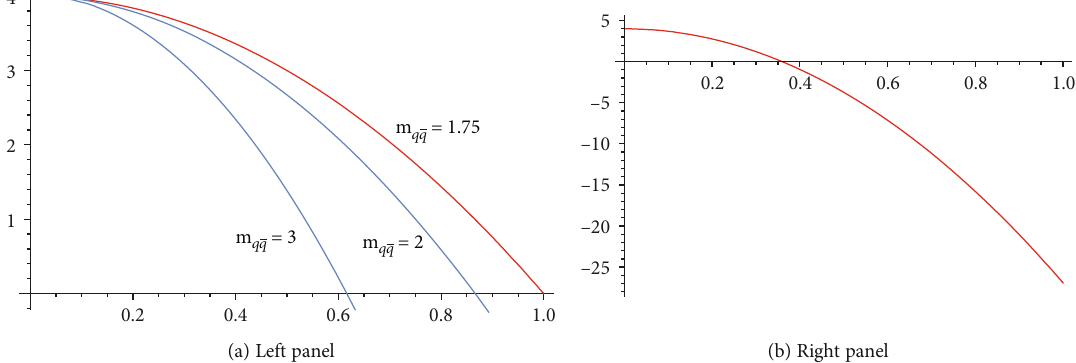
ð r , m Þ against ( r , m s q (cid:1) q